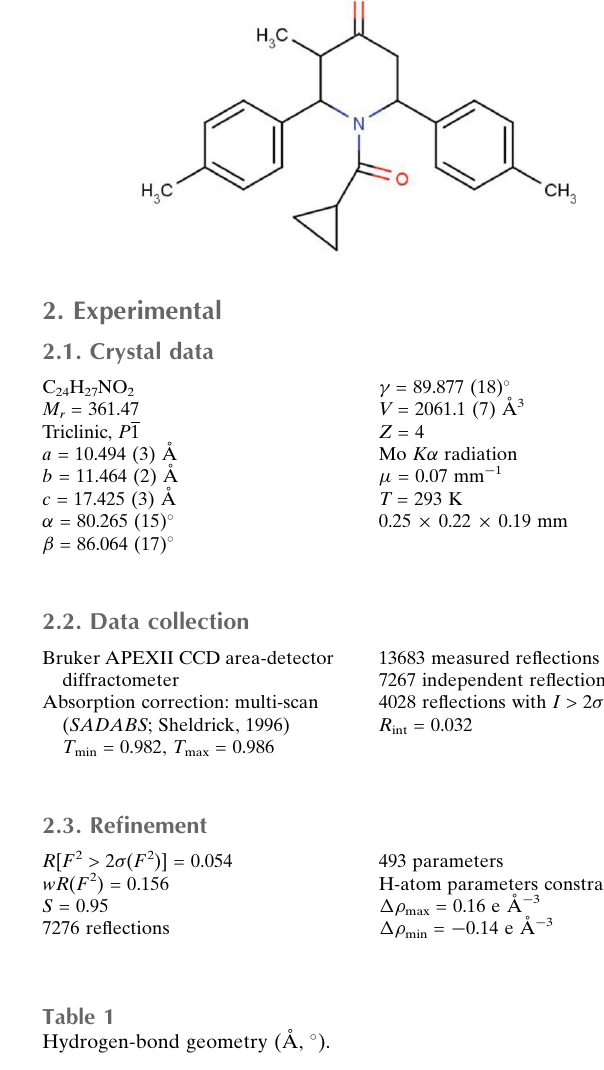
Hydrogen-bond geometry (A˚ , (cid:3)